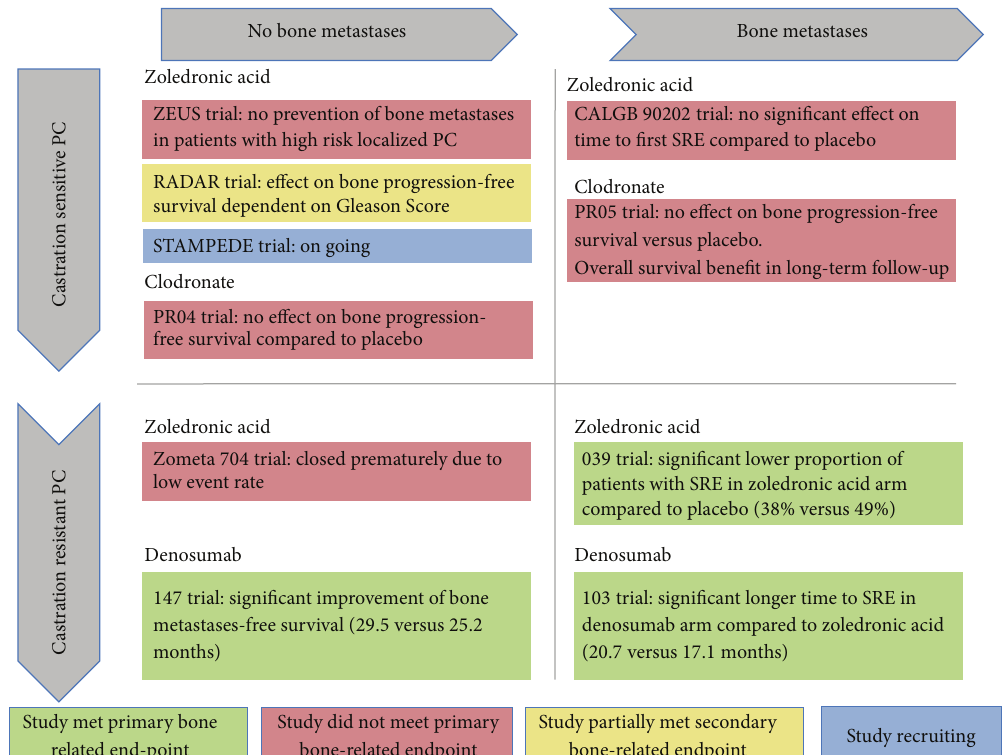
Figure 1: Summary of phase III trials investigating the use of antiresorptive drugs in the context of castration sensitive and castration resistant prostate cancer (PC) with and without bone metastases. SRE: skeletal related